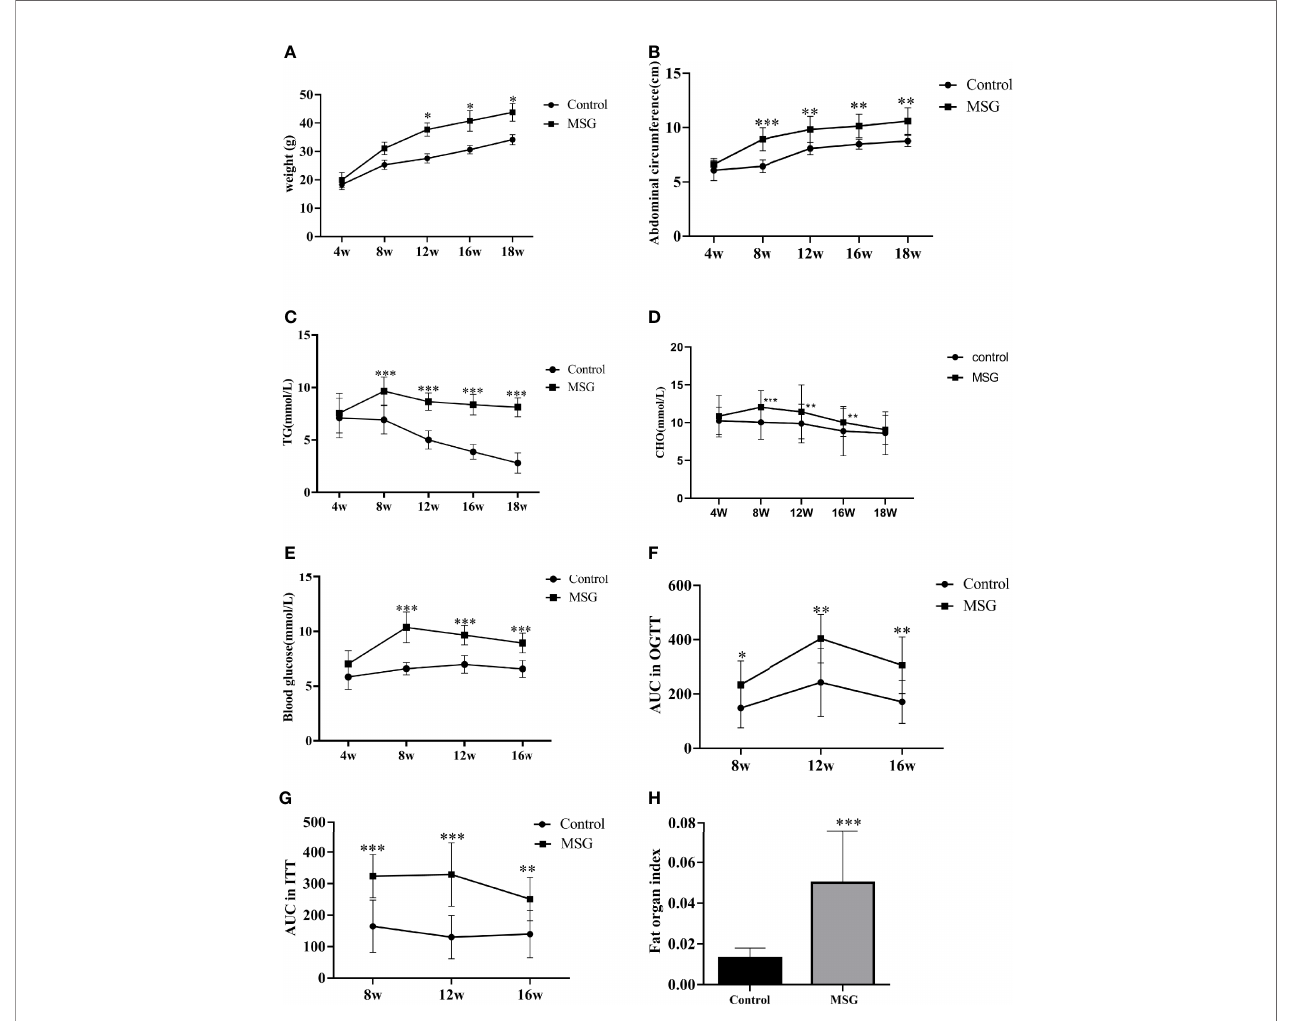
FIGURE 4 | Characteristics of the MSG mouse model. (A) Weight change curves of the normal control group and MSG mice. (B) Abdominal circumference curve of the normal control group and MSG mice. (C) Changes of serum TG in the normal control group and MSG mice at different time points. (D) CHO change curves in serum of the normal control group and MSG mice at different time points. (E) Changes of fasting blood glucose in the normal control group and MSG mice at different time points. (F) Area under OGTT curve (AUC) of oral glucose tolerance of the normal control group and MSG mice at 8, 12, and 16W. (G) Area under insulin tolerance (ITT) curve (AUC) of the normal control group and MSG mice at 8, 12, and 16W. (H) Fat index of the normal control group and MSG mice at dissection vs. control group: * p < 0.05, ** p < 0.01, *** p <